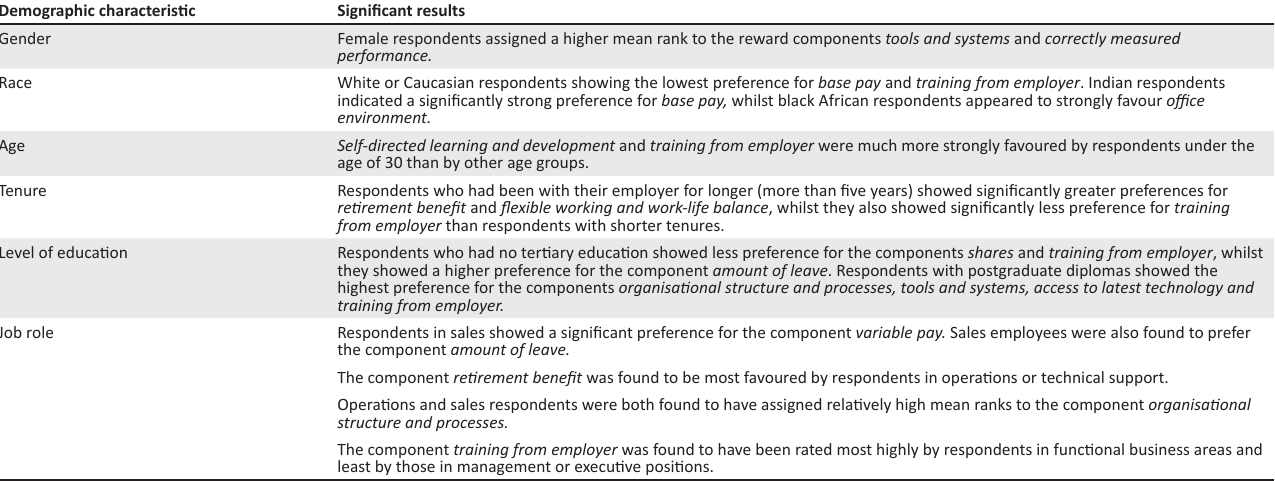
TABLE 5: Summary of significant differences found in the impact of demographic characteristics on reward preferences. Demographic characteristic Significant